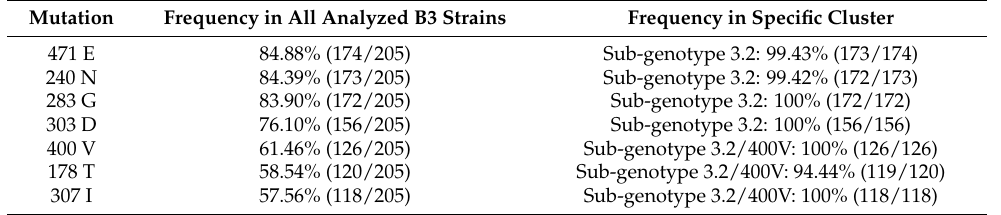
Table 1. Frequency of amino acid